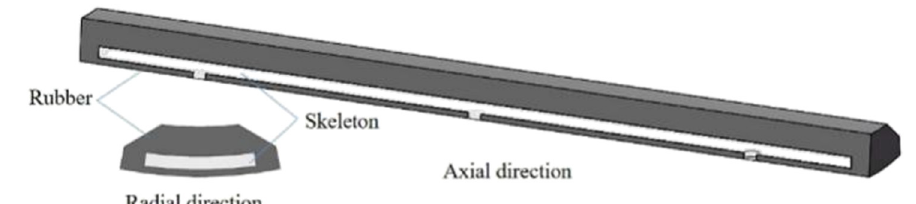
Figure 2: Typical structure of the rubber stave.